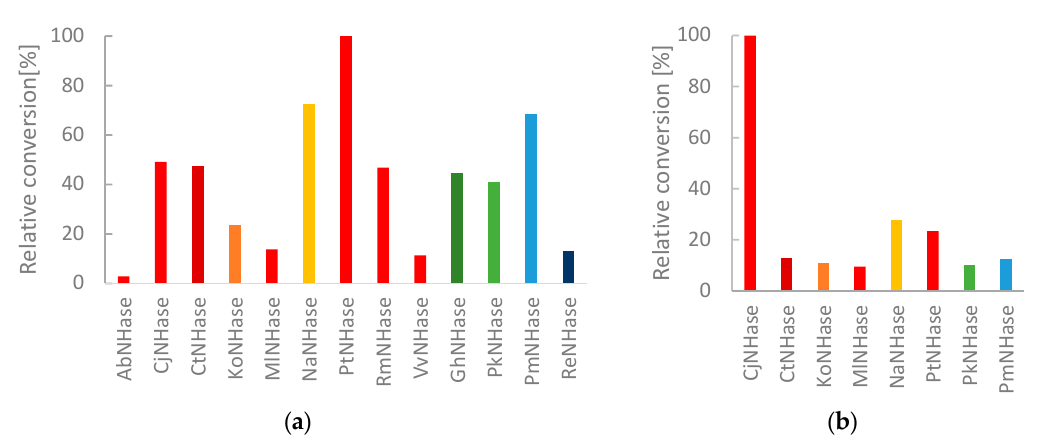
Figure 6. Amide formation from 5 mM substrate. Reaction time 5 min. Red tones: Co- and Green/Blue Fe-dependent NHases. ( a ) 3a with NHase CFEs (1:200 dilution) in 100 mM KH 2 PO 4 buffer at pH 7.2 and 25 °C. All missing NHases were inactive for 3a hydration under these conditions. ( b ) 4a with NHase CFEs (1:100 dilution) in 273 mM Na 2 HPO 4 /72 mM NaH 2 PO 4 at pH 7.5. All omitted NHases were inactive for 4a hydration under these conditions.